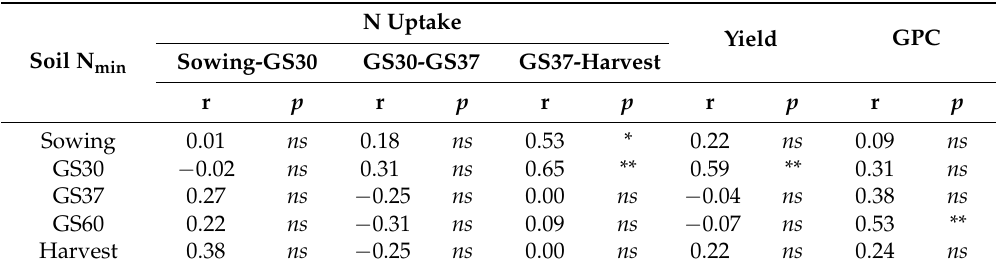
Table 5. Pearson correlation coefficients (r) among the soil N min values, N uptake values between sowing and stem elongation (GS30), GS30 and leaf flag emergence (GS37), GS37 and flowering (GS60), and yield and GPC (grain protein